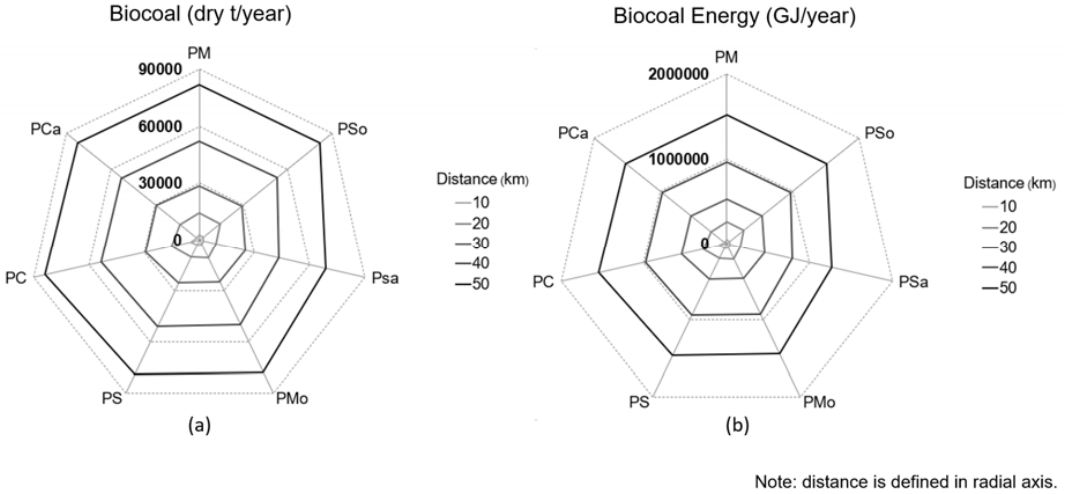
Figure 5. Mass and energy per candidate node in the study area: ( a ) biocoal (m b ), ( b ) bioenergy (E b